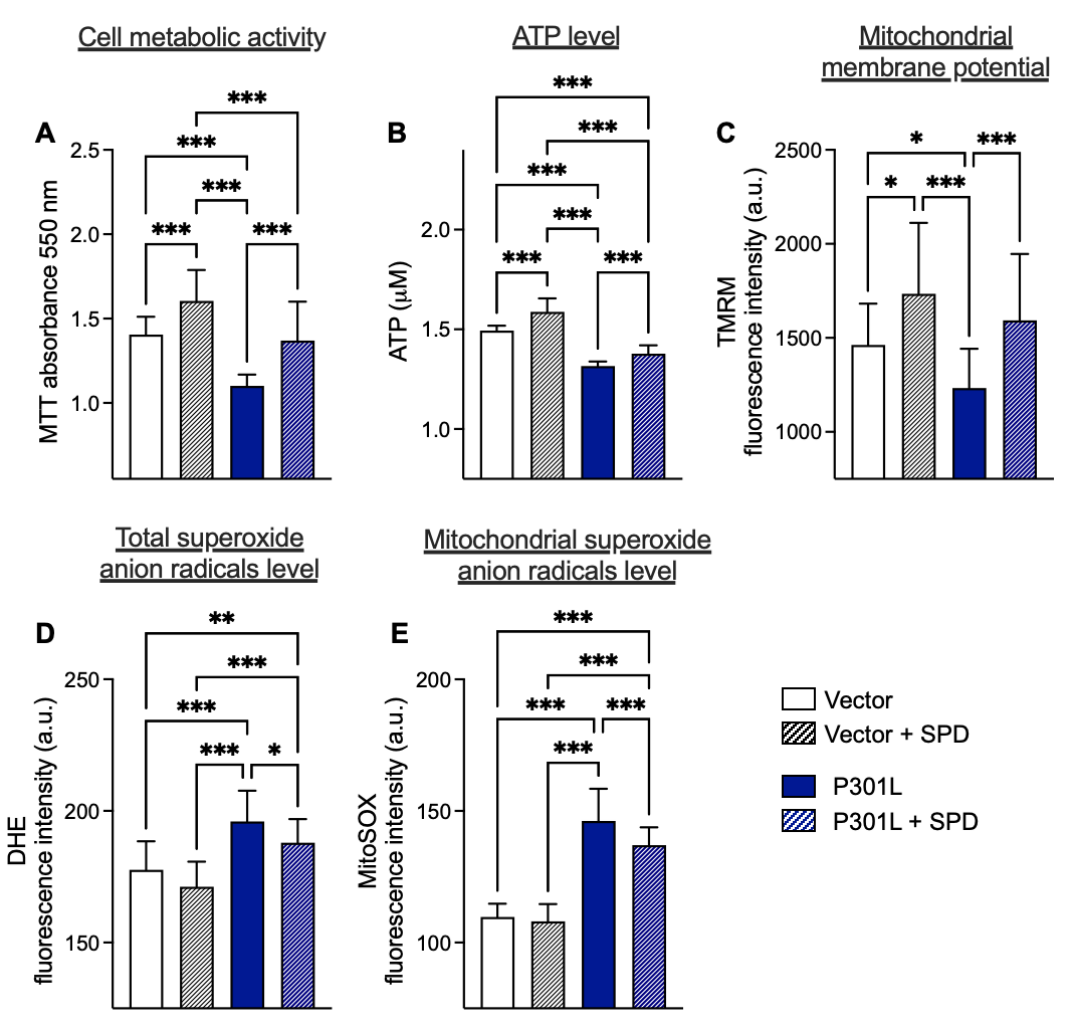
Figure 2. Improved mitochondrial bioenergetics and decreased reactive oxygen species levels by spermidine in control and P301L cells. Cells were treated with 0.1 μ M spermidine for 48 h. ( A ) Cell metabolic activity in vector and P301L cells. ( B ) ATP concentration in vector and P301L cells. ( C ) Mitochondrial membrane potential in vector and P301L cells. ( D ) Total superoxide anion level in vector and P301L cells. ( E ) Mitochondrial superoxide anion level in vector and P301L cells. Data are presented as mean ± SD (N = 25 – 30 replicates/conditions). * p < 0.05; ** p < 0.01; *** p < 0.001; one- way ANOVA and post hoc Tukey ’ s multiple comparisons test. MTT: MTT assay, SPD: spermidine,